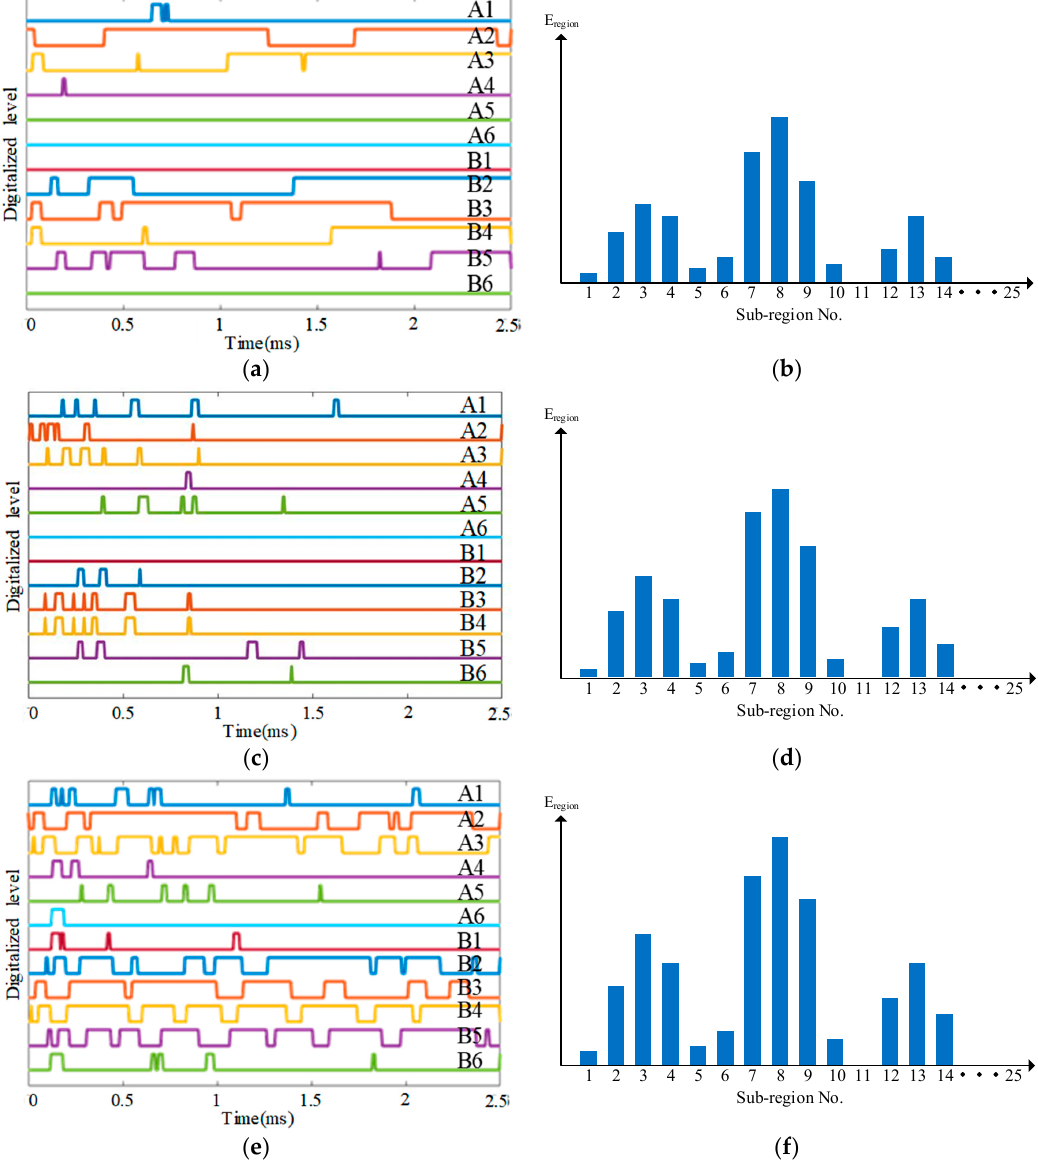
Figure 25. Typical impact region monitoring results on the UAV composite skin based on CSSN under different energy levels: ( a ) CDSs and ( b ) E region of all sub-regions under energy level 1; ( c ) CDSs and ( d ) E region of all sub-regions under energy level 2; ( e ) CDSs and ( f ) E region of all sub-regions under energy level 3.